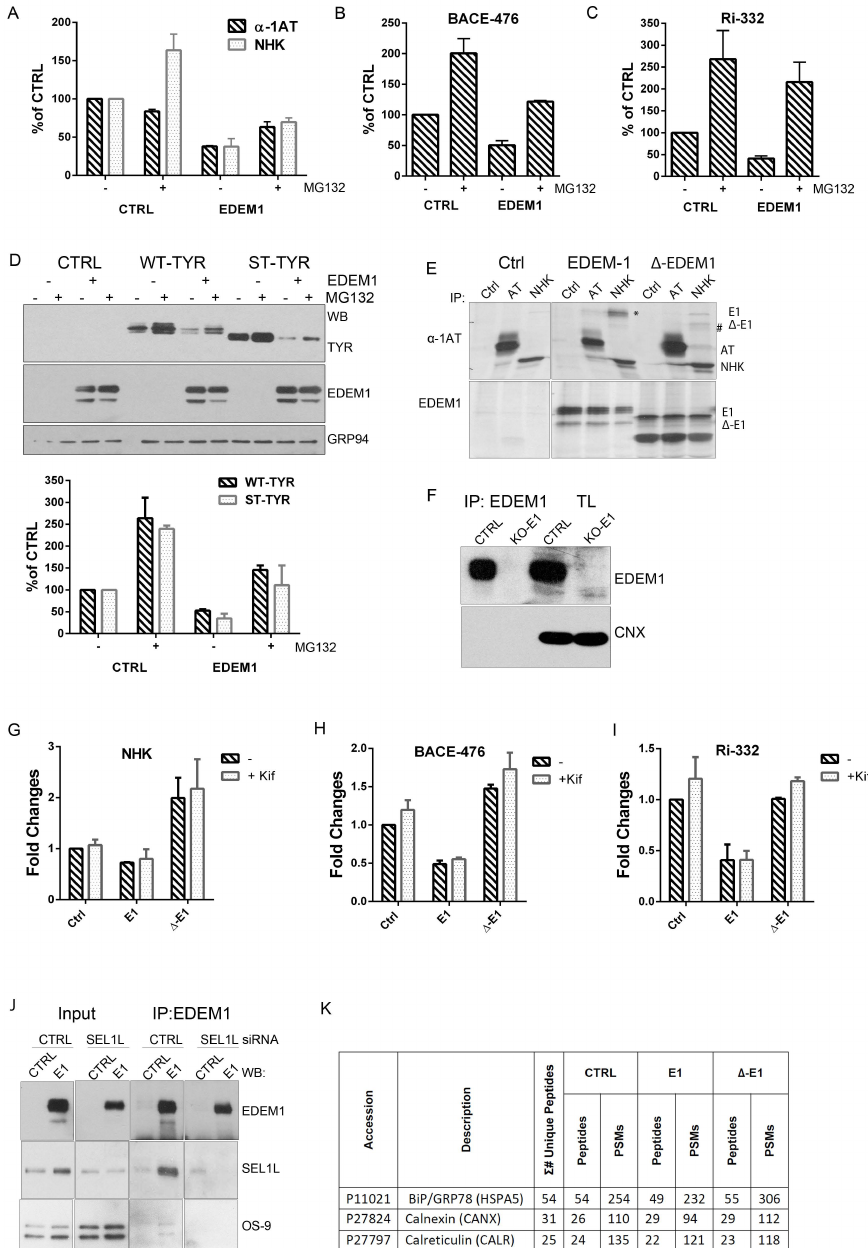
Figure A1. (A – C) Band densitometry plots of α -1AT and NHK ( A ), BACE-476 ( B ), and Ri-332 ( C ), co-expressed in HEK293T with an empty vector (CTRL) or EDEM1 (EDEM1), treated or not with MG132, as presented in Figure 2A–C (mean n = 2 ± SEM). ( D ) Cells overexpressing EDEM1 alongside an empty vector (CTRL), WT-Tyr, or its truncated variant ST-Tyr were treated or not with MG132. The pelleted cells were lysed in a Triton-X100-containing bu ff er, and equal amounts of proteins were separated in reducing conditions by SDS-PAGE.Protein expression was detected by Western blotting using antibodies against α -Tyr, EDEM1, or GRP94 (upper panel); the lower panel depicts band densitometry plots for WT-Tyr and ST-Tyr (mean n = 2 ± SEM). ( E ) HEK293T co-expressing an empty vector (CTRL), EDEM1 (E1), or ∆ -EDEM1 ( ∆ -E1) with α -AT (AT) and NHK were metabolically labelled with 35 S-Met / Cys for 20 min. Harvested cells were lysed in a CHAPS-containing bu ff er, and cleared lysates were subjected to immunoprecipitation with antibodies for α -AT (upper panel) and EDEM1 (lower panel). The